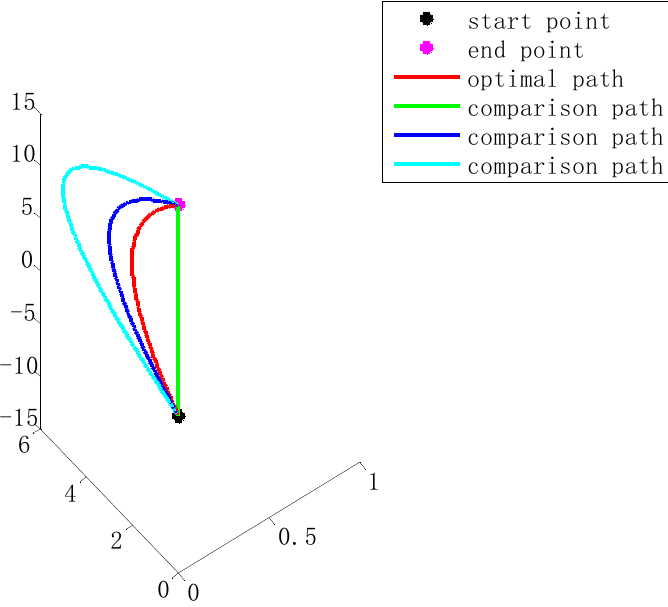
Figure 8. Schematic diagram of the different climbing paths of the inchworm robot. Table 1. Parameters of the different paths.